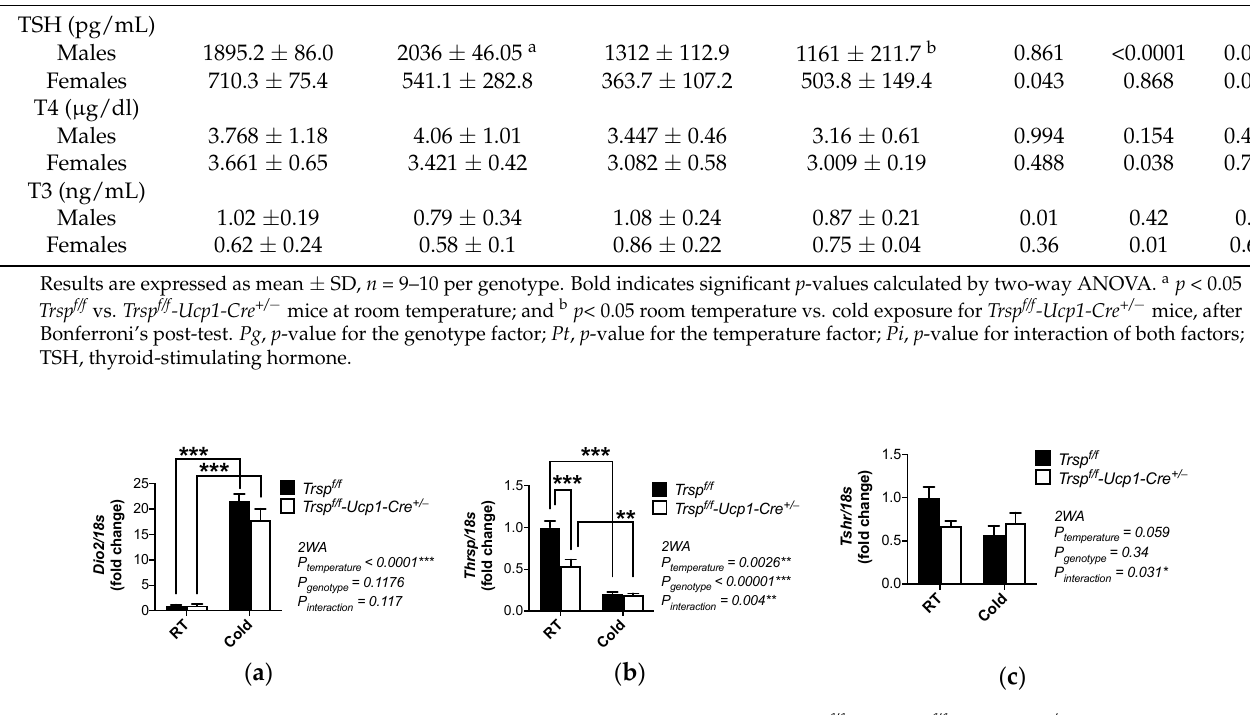
Figure 9. Gene expression of transcripts involved in methylation pathways in male Trsp f/f and Trsp f/f -Ucp1-Cre +/ − mice. Expression of ( a ) Mthfd2 and ( b ) Nnmt were assessed by qPCR. RT, room temperature. Data are mean + SD; n = 8–10 per genotype. p -values are displayed in graphs and were calculated by two-way ANOVA (2WA) followed by Bonferroni's post test; * p < 0.05, ** p < 0.01, and *** p < 0.001. 3. Discussion We have reported the development of a novel transgenic mouse model, the Trsp f/f - Ucp1-Cre +/ − mice. Our model was characterized by targeted deletion of the gene Trsp in brown adipocytes, which are the primary cell type of BAT. The product of the Trsp gene, tRNA [Ser}Sec , is responsible for carrying out the synthesis of selenoproteins, including Dio2, a regulator of cold-induced adaptive thermogenesis in BAT. Dio2 upregulation is promoted by thyroid hormone and is considered a primary in- dicator of activation of adaptive thermogenesis in cold exposure [44]. In males, Dio2 ex- pression was unchanged between Trsp f/f and Trsp f/f -Ucp1-Cre +/ − mice, despite a reduction